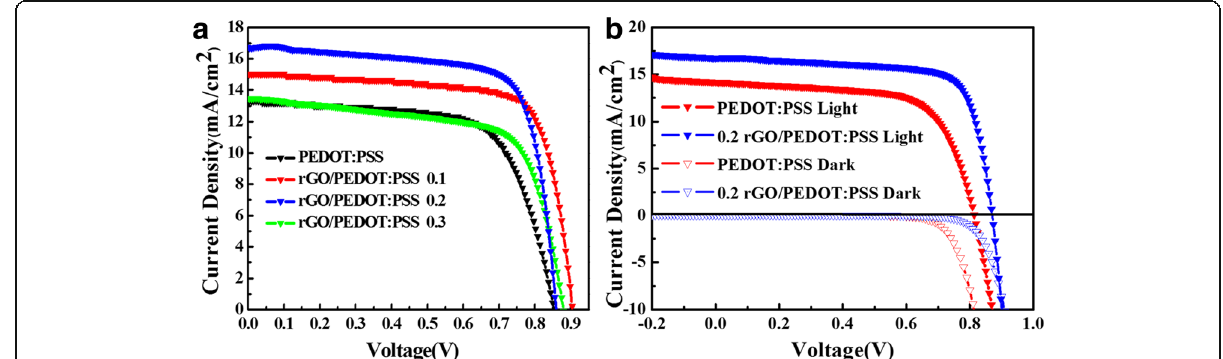
Fig. 5 a J – V curves of the PSC with pristine PEDOT:PSS and PSCs with rGO/PEDOT:PSS at different volume ratios. b J – V curves of PSCs with pristine PEDOT:PSS as HTL (red lines) and PSCs (blue lines) with rGO/PEDOT:PSS (0.2 v / v ) as HTL measured under simulated AM1.5 sunlight of